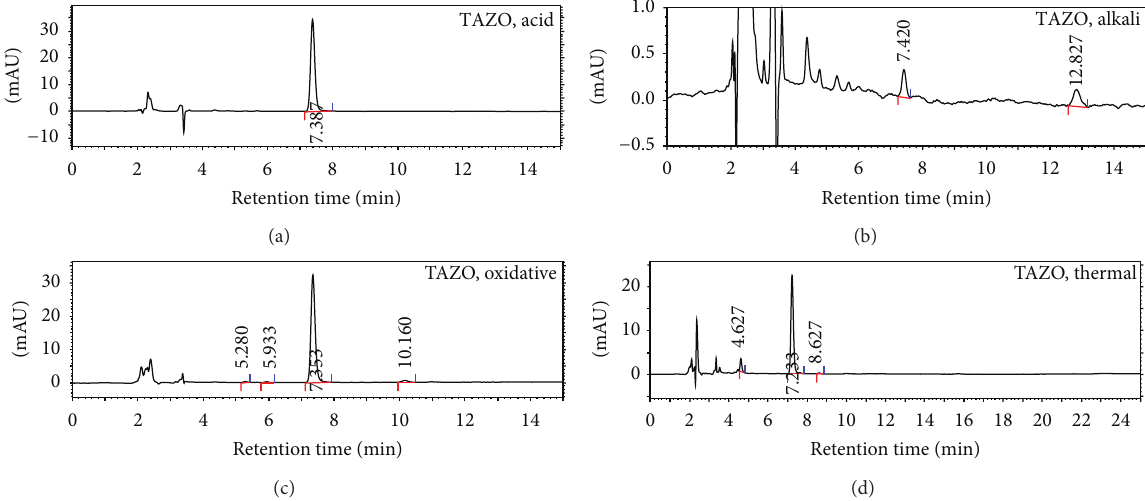
Figure 4: Chromatogram of specificity study of TAZO ((a) acid stress (b) alkali stress (c) oxidative stress and (d) thermal stress).